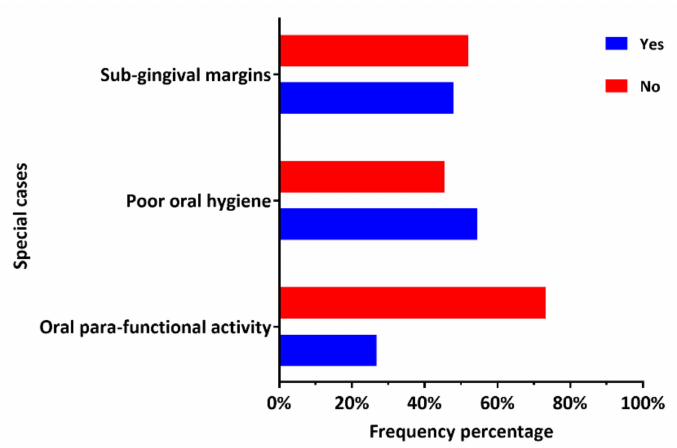
Figure 2. Dental practitioner-reported frequency of the placement of composite in special cases.